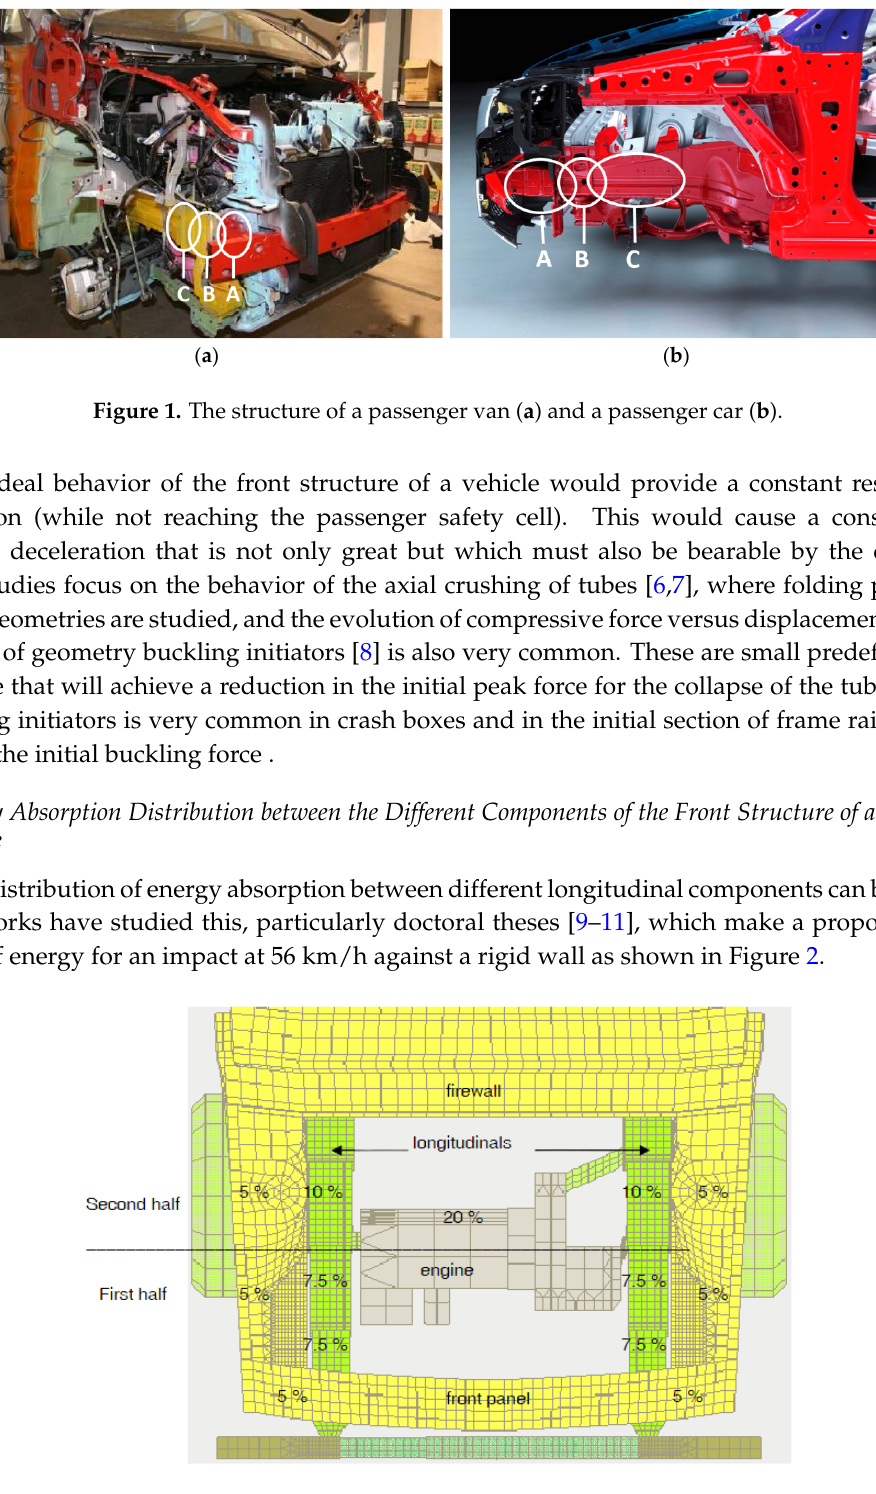
Figure 2. Estimated energy absorption percentages in the frontal structure of an automobile.